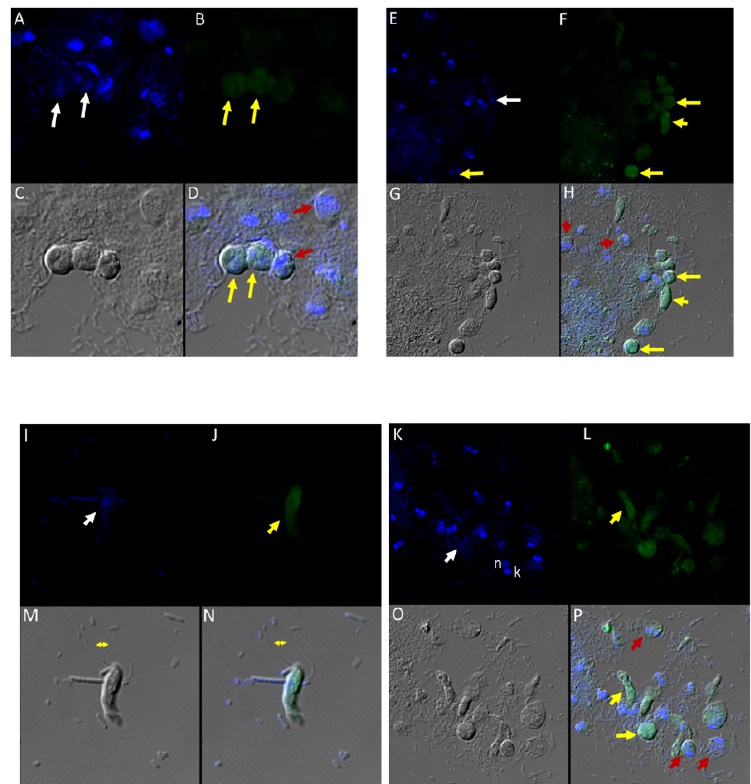
Figure 8. ( A – H ): Immunofluorescence microscopy of Colpodella sp. (ATCC 50594) trophozoites and cysts using anti-IMC3 antibody. ( A , E ); two-nuclei cysts of Colpodella sp. (ATCC 50594) were identified by DAPI staining (white arrows, panel A ), single nucleus cyst is shown in panel ( E ) (white arrow). ( B , F ); Antibody reactivity was observed on cysts (yellow arrows) and trophozoites (yellow arrowheads) of Colpodella sp. (ATCC 50594). ( C , G ); DIC microscopy showing the morphology or trophozoites and cysts of predator and prey. ( D , H ); Merged antibody, DAPI and DIC images showing no reactivity of anti-IMC3 antibodies with P. caudatus cysts (red arrows, panel D ) and trophozoites (red arrowheads, panel H ), antibody reactivity with Colpodella sp. (ATCC 50594) cysts (panels D and H , yellow arrows). ( I – P ): Immunofluorescence microscopy of Colpodella sp. (ATCC 50594) trophozoites and cysts using anti-IMC3 FLR antibody. ( I , K ); DAPI stained nuclei of Colpodella sp. (ATCC 50594) trophozoites (white arrows, panels I and K ) and P. caudatus trophozoites showing nucleus (n) and kinetoplast (k) (panel K ). ( J , L ); anti-IMC3 FLR antibody reactivity is shown on trophozoites and cysts of Colpodella sp. (ATCC 50594) (yellow arrowheads and arrow). ( N , P ); Merging of antibody, DAPI and DIC image. Antibody reactivity was not observed on P. caudatus trophozoites (red arrowheads, panel P ) while ant-IMC3 FLR reactivity was observed on trophozoites and cysts of Colpodella sp. (ATCC 50594) (yellow arrow and arrowhead). Flagella of Colpodella sp. (ATCC 50594) were identified (double arrow, panels M and N ).